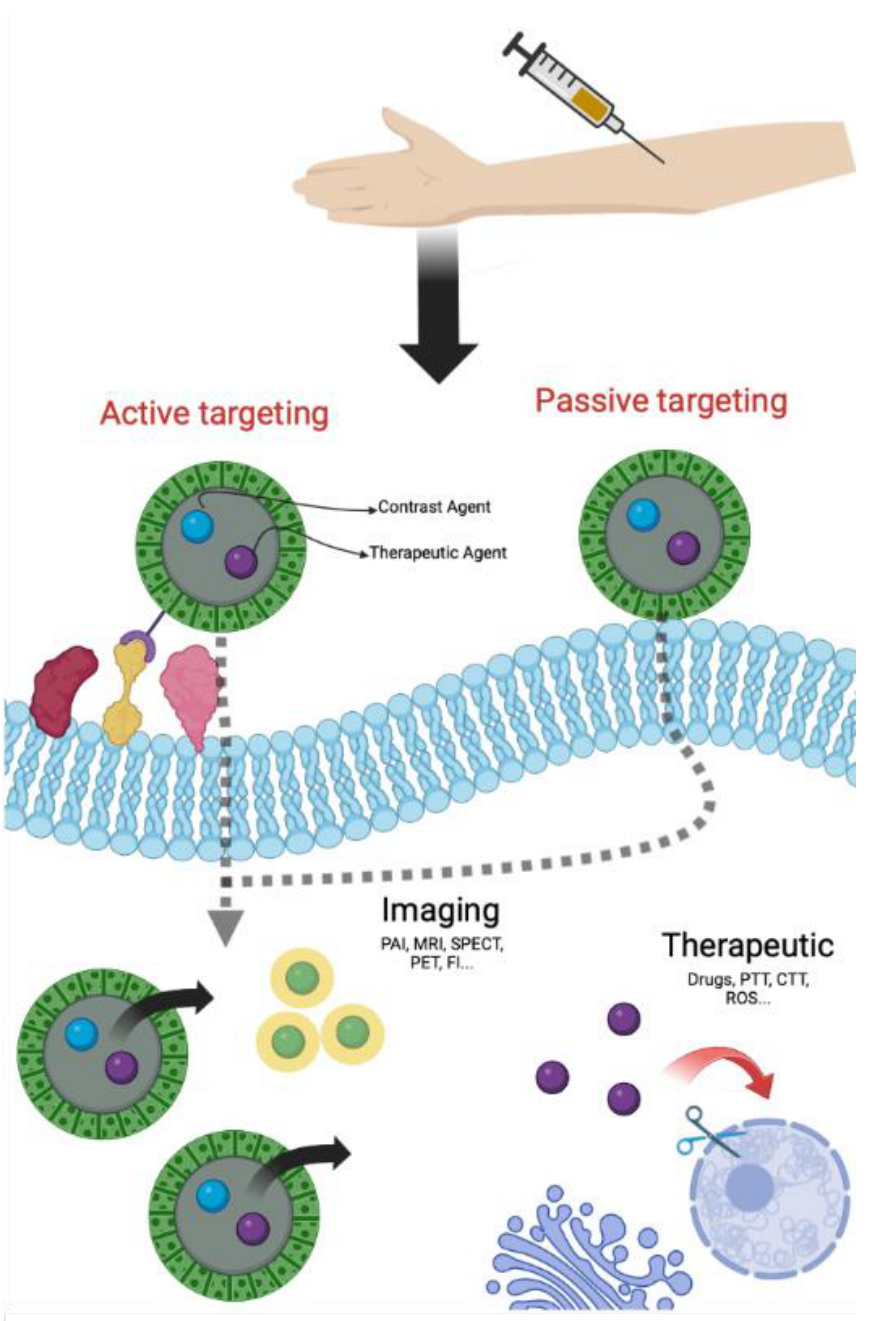
10 September Figure 1. General scheme of theranostic approach (Created with BioRender.com, accessed on 10 September 2022).